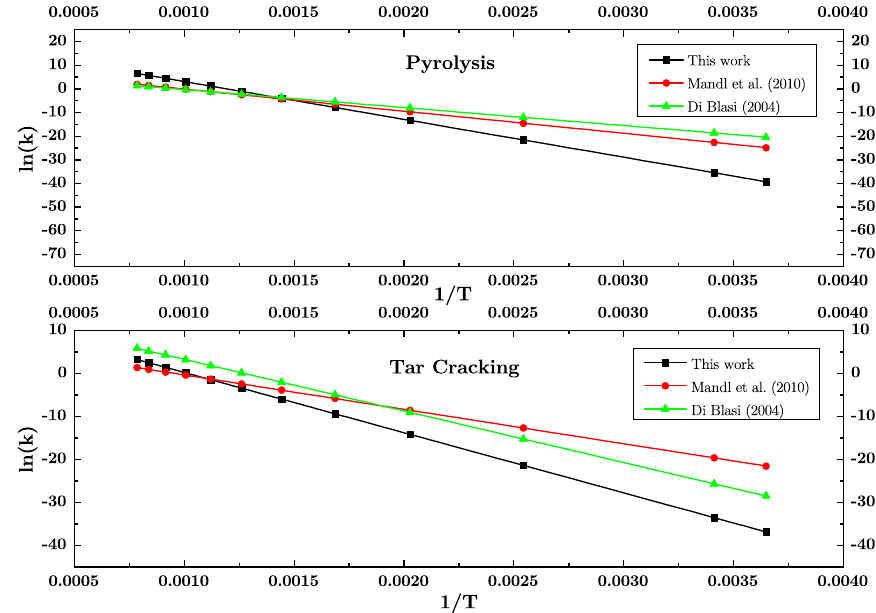
Figure 3. Rates of pyrolysis (1/s) and tar cracking (1/s) used in